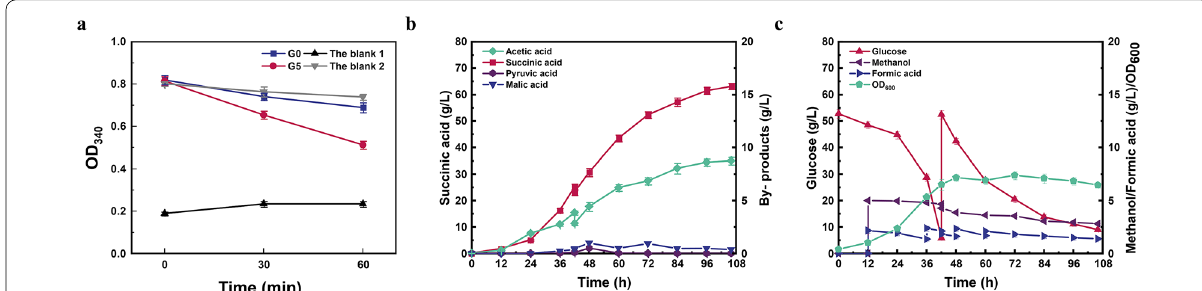
Fig. 5 a Measuring the extracellular enzyme activity of Pyc in strain G5, the blank 1 and 2 were the reaction solution without NADH and pyruvic acid, respectively. b , c Fed-batch fermentation of strain G5 with C1-substrates